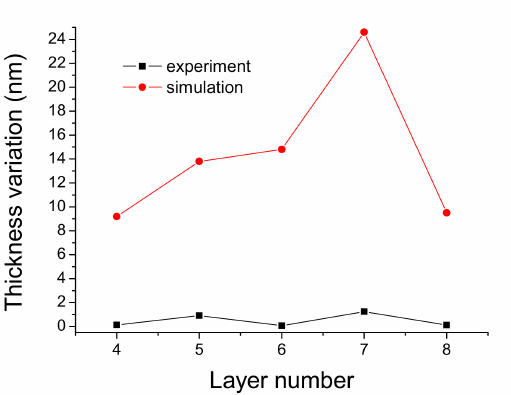
Figure 5. Comparison of the thickness variation in simulated layers 4–8 by reducing 0.5% reflectivity to the thickness variation in the experimental layers controlled by an optical